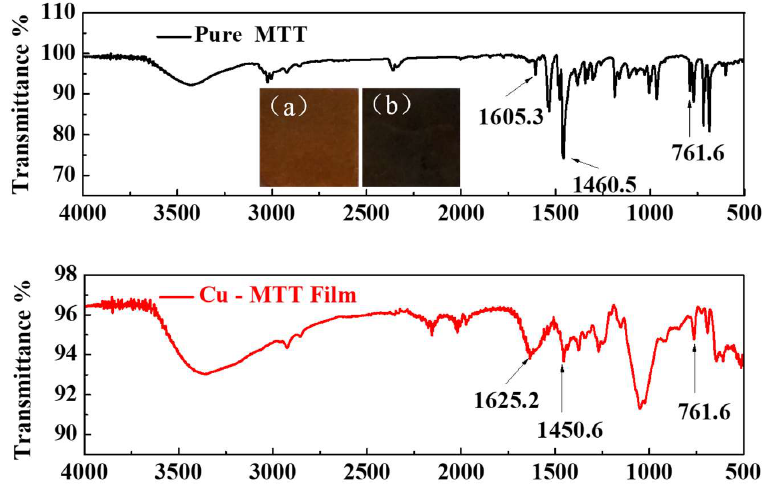
Figure 7. FT-IR spectra of MTT powder and Cu-MTT film. (Insets: morphologies for ( a ) pure copper and ( b ) after immersed in 5 mM MTT).